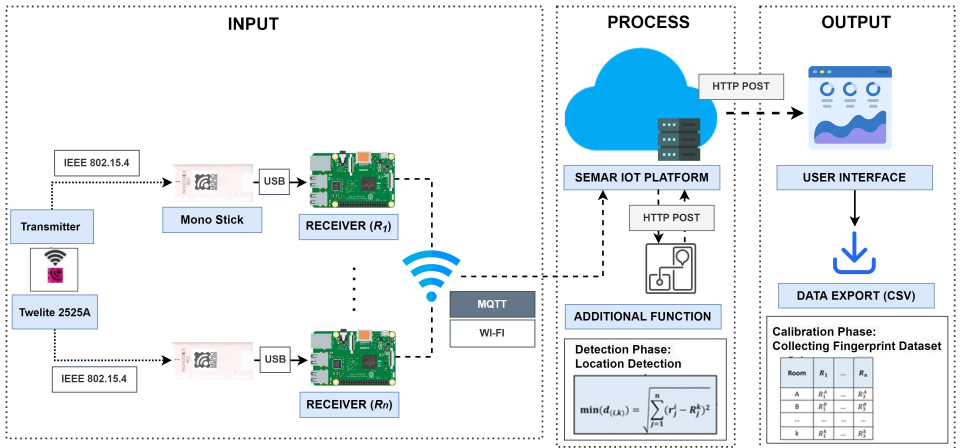
Figure 16. System overview of FILS15.4